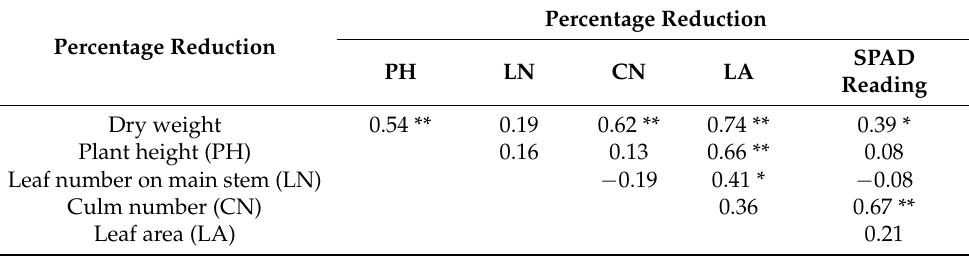
Table 4. Correlation coefficients between percentage reductions in different agronomic